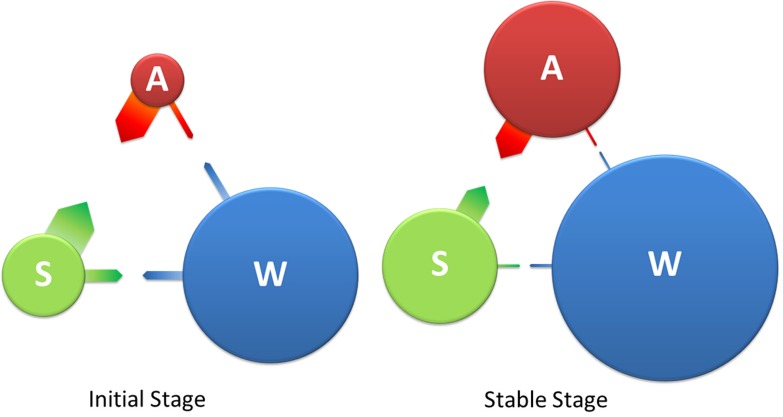
Schematic representation of the microbial interactions in the abalone seed-nursing ecosystem.A, Abalone; S, Adherent substrate; W, Water. The diameters of the circles reflect the inner BC% (BCAn-1—An%, BCSn-1—Sn%, or BCWn-1—Wn%), and the thicknesses of the arrows reflect the external BC% (for example, the arrow from S to A represents the average value of BCSn-1—An% and BCSn—An%).